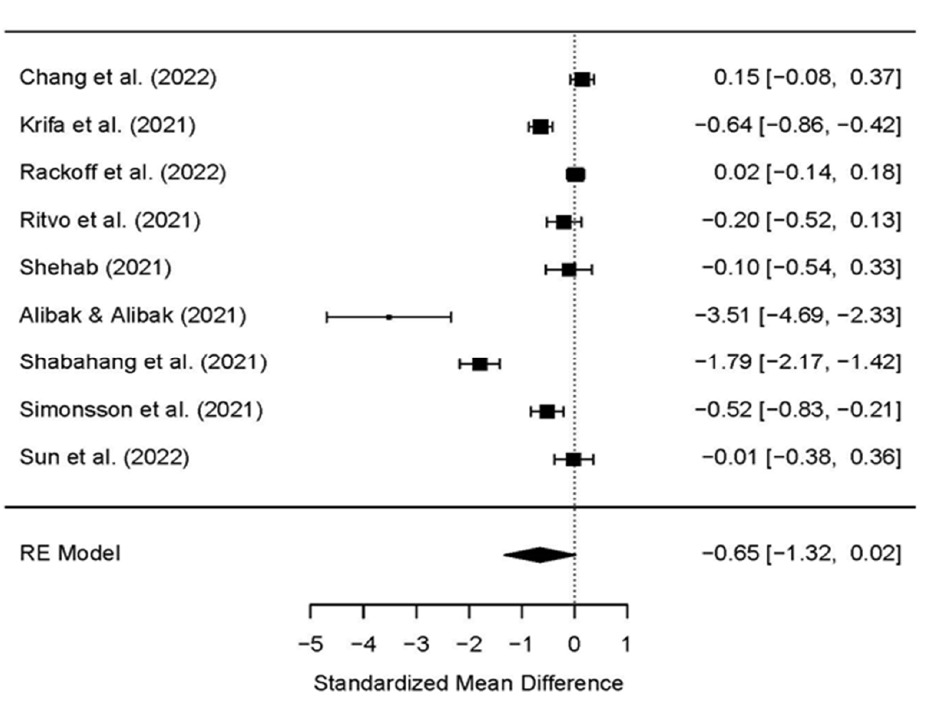
Figure 3. The effects of psychological interventions on reducing anxiety among university students during COVID-19 in the included randomized controlled trials [32,34–41].